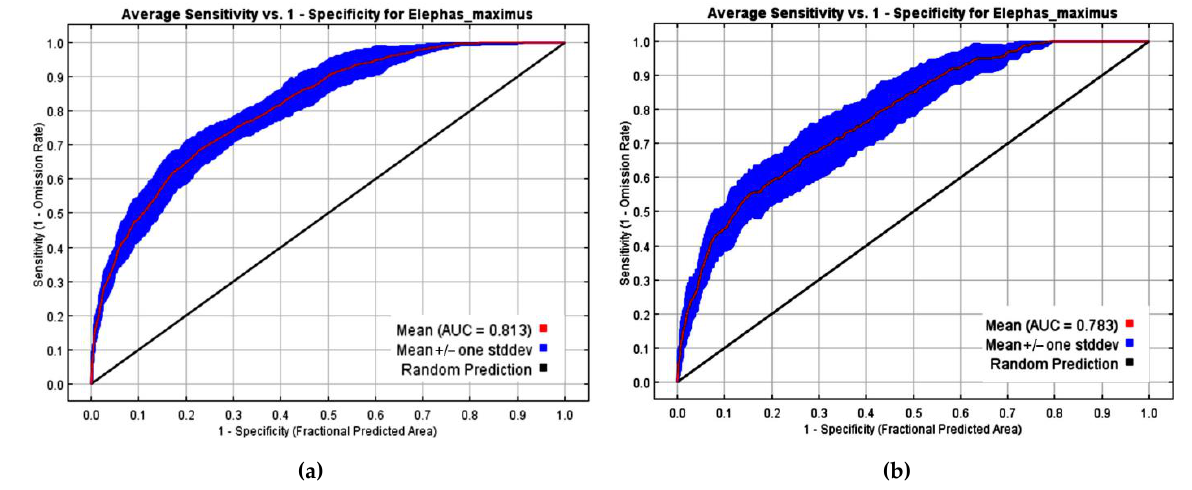
Figure 5. The area under the Receiver Operating Characteristic (ROC) curve (AUC) of wild elephant distribution models in 2020: ( a ) the dry season and ( b ) the wet season.